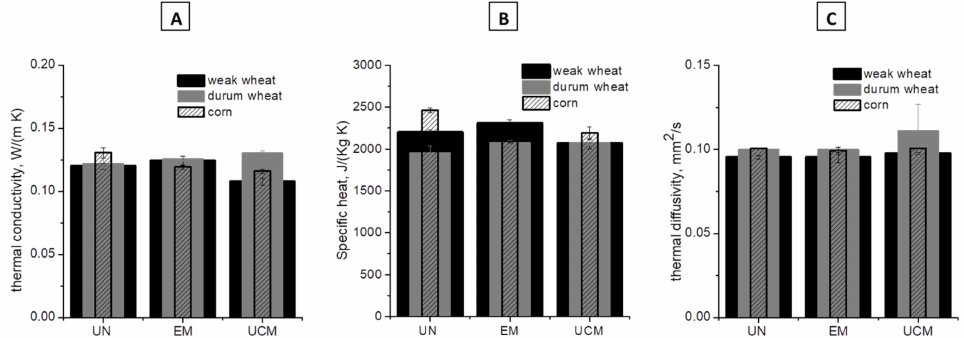
Figure 1. Thermal properties (( A ) thermal conductivity, ( B ) specific heat, and ( C ) thermal di ff usivity) in tapped density conditions of untreated (UN), e ff ective treated (EM), and uncontrolled treated (UCM), in black column, powdered weak wheat (moisture—tapped density: UN = 10.6 ± 0.3 wb%–0.74 ± 0.01 g / mL; EM = 10.3 ± 0.4 wb%–0.77 ± 0.00 g / mL; UCM = 6.3 ± 0.3 wb%–0.70 ± 0.02 g / mL), in gray column, durum wheat (moisture—tapped density: UN = 6.3 ± 0.4 wb%–0.75 ± 0.00 g / mL; EM = 8.0 ± 0.4 wb%–0.73 ± 0.01 g / mL; UCM = 7.3 ± 0.3 wb%–0.74 ± 0.00 g / mL), in striped column, corn (moisture–tapped density: UN = 10.5 ± 0.2 wb%–0.74 ± 0.00 g / mL; EM = 9.4 ± 0.3 wb%–0.69 ± 0.02 g / mL; UCM = 6.0 ± 0.1 wb%–0.67 ± 0.00 g /